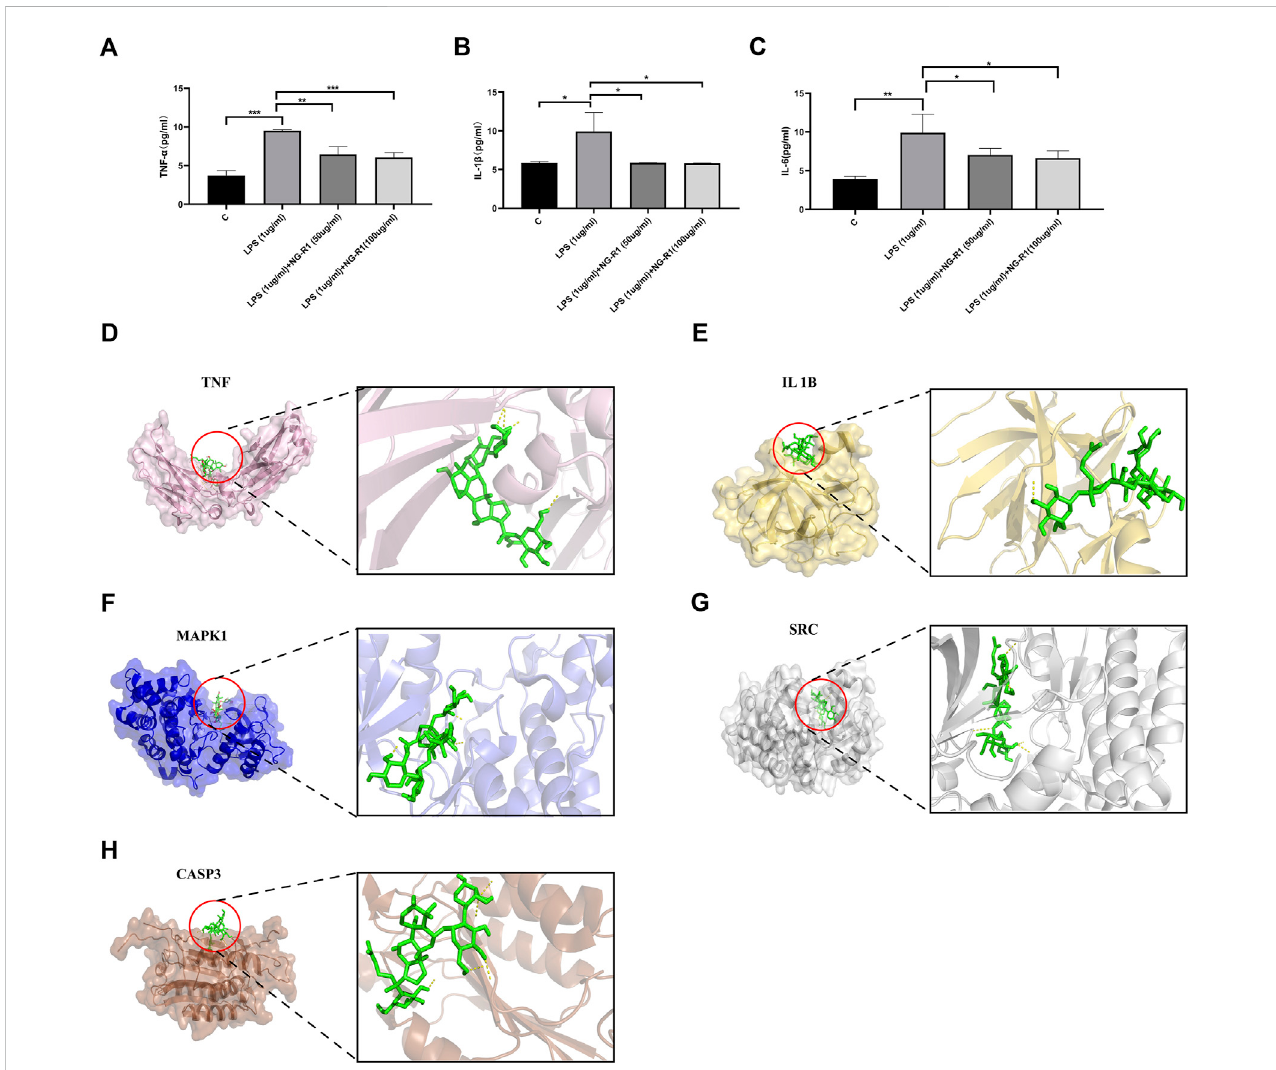
FIGURE 7 Analysis of in fl ammatory factor expression and molecular docking results in myocardial injury cells after NG-R1 treatment. (A – C) ELISA assay results show the levels of TNF- α , IL-1 β and IL-6 in AC16 cardiomyocytes of different treatment groups ( n = 3 per group). (D) Docking results of TNF and NG-R1 with docking energy − 6.8 kcal/mol (surface structure and cartoon structure). (E) Docking results for IL1B and NG-R1, docking energy − 6.8 kcal/mol (surface structure and cartoon structure). (F) Docking results of MAPK1 and NG-R1 with docking energy − 8.6 kcal/mol (surface structure and cartoon structure). (G) Docking results of SRC and NG-R1 with docking energy − 8.9 kcal/mol (surface structure and cartoon structure). (H) Docking results of CASP3 and NG-R1 with docking energy -5.7 kcal/mol (surface structure and cartoon structure). The data are represented as means ± SD; * p < 0.05, ** p < 0.01, *** p <